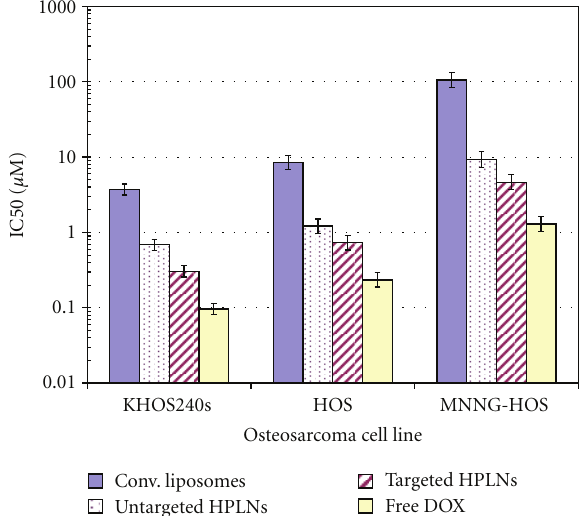
Figure 8: Cytotoxicity IC50s for doxorubicin-loaded vehicles and free DOX. Targeted and untargeted hybrid PLNs were incubated with osteosarcoma cell lines in comparison to free doxorubicin and conventional PEG-liposomal doxorubicin. Mean log IC50 for osteosarcoma cell lines shows that untargeted hybrid PLNs have a 6-fold increase in cytotoxicity over conventional liposomal formu- lation. ALCAM targeted hybrid PLNs (HPLN) show an additional 2-fold increase over untargeted HPLNS and 12-fold increase in cytotoxicity over conventional PEG-liposomal doxorubicin. Geo- metric mean IC50s were derived from seven, five, and three sets of MTT assay experiments in, respectively, the KHOS240s, HOS, and MNNG-HOS cell lines. Error bars correspond to 1 standard error for mean log (IC50). Within each cell line, di ff erences among vehicles are highly significant ( P < 0 . 0001). Confidence intervals for pairwise ratios of IC50s, corrected for multiple comparisons, are summarized in Table